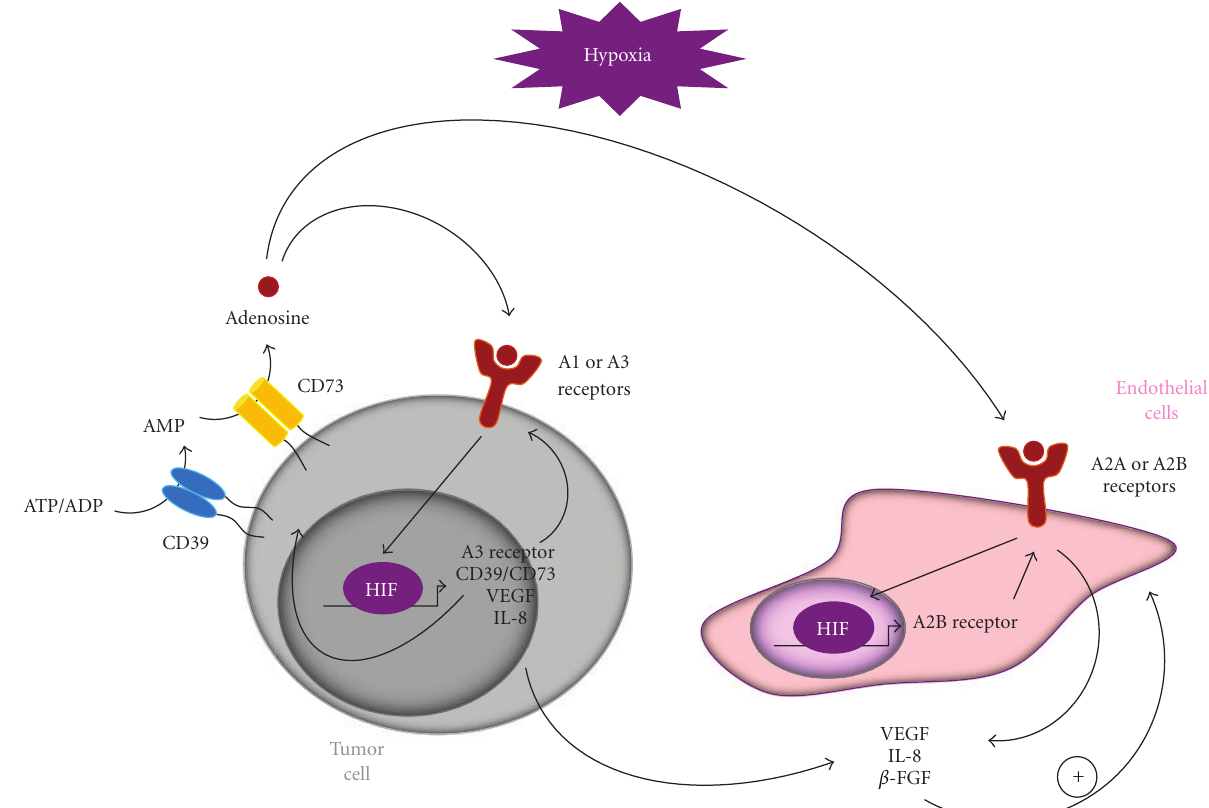
Figure 2: Hypoxia mediated expression of ectonucleotidases and adenosine receptors. HIF is induced under hypoxic conditions in cancer cells and directly increases the expression of (1) ectonucleotidases CD39 and CD73, which generate adenosine from ATP/ADP, (2) adenosine receptors that could, after binding of adenosine, activate HIF, and (3) angiogenic molecules VEGF and IL-8. These (again with β -FGF) also produced by endothelial cells (through binding of adenosine on specific receptors) could induce proliferation of these cells. microenvironment such as TNF- α , IL-1 β [58], prostaglandin E2 (PGE2) [59], TGF- β [60], and IL-6 [61] could also